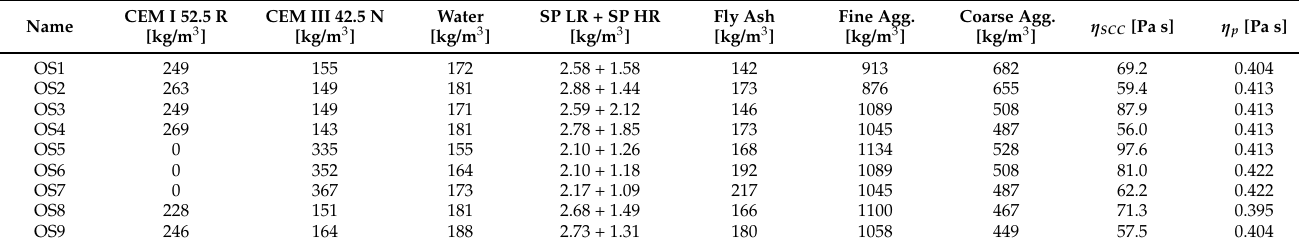
Table A5. Dosages and dynamic viscosities of the self-compacting concretes in Grünewald